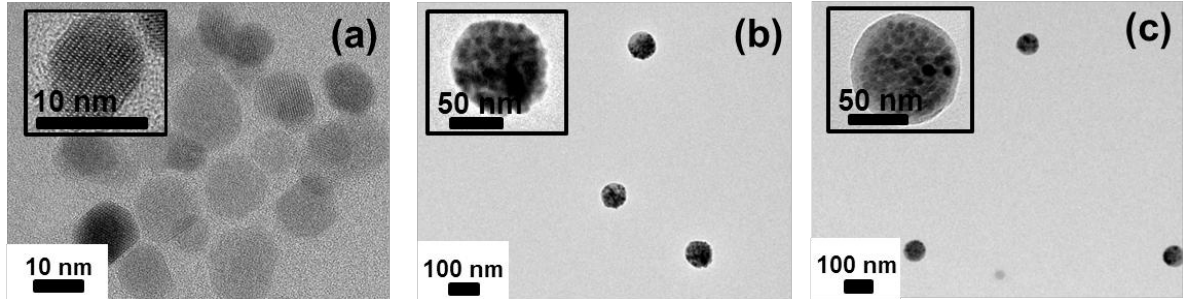
O -PSt and ( c ) Fe 3 4